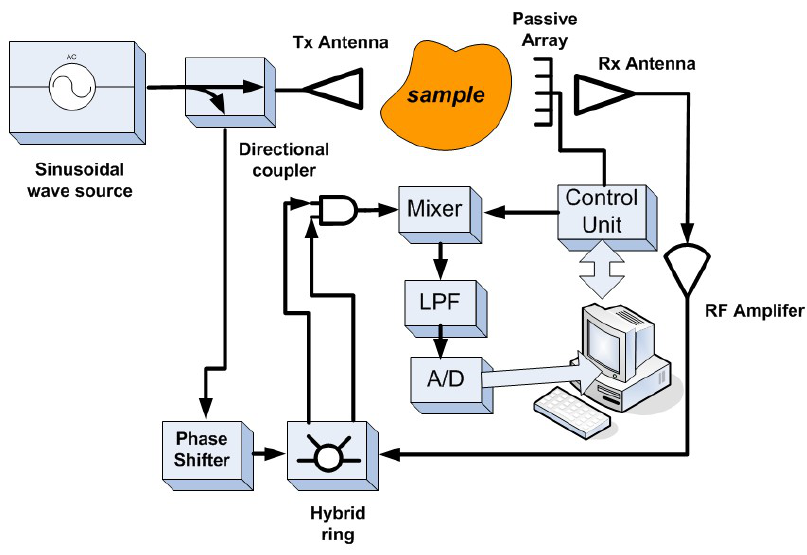
Figure 31. Modulated scattering microwave imaging system